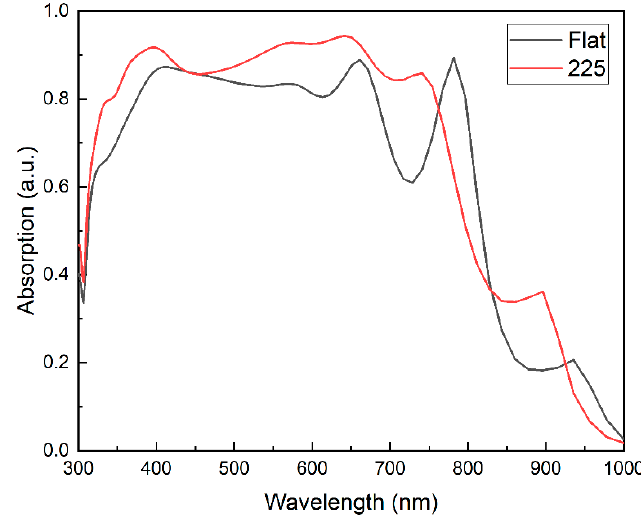
Figure 4. Absorption spectra for PSC without (flat) and with 225 nm radius of nanodisk photonic crystals. The photonic crystals lead to the absorption enhancement of PSC.